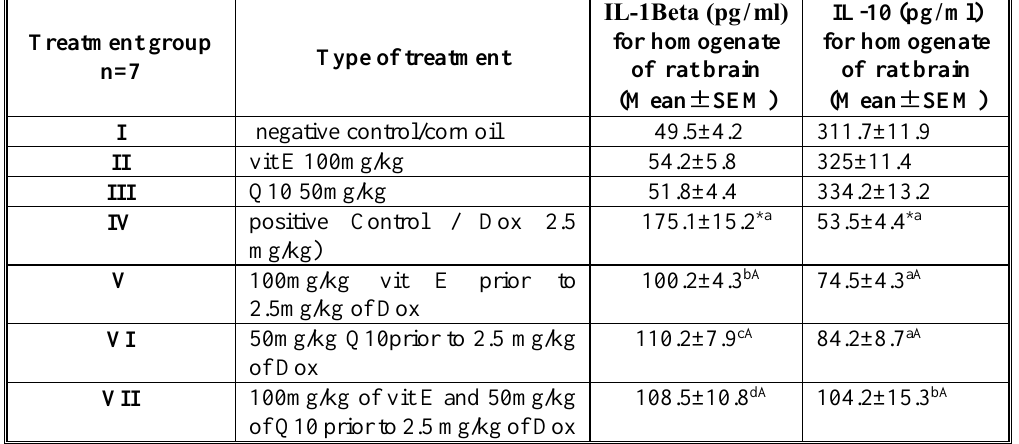
Table 1. Effect of Coenzyme Q10 and Vitamin E each alone and in combination on interlukine- 1Beta (IL-1β) and interlukine-10 (IL-10) levels in brain tissue homogenate after intraperitoneal injection of doxorubicin (DOX) in